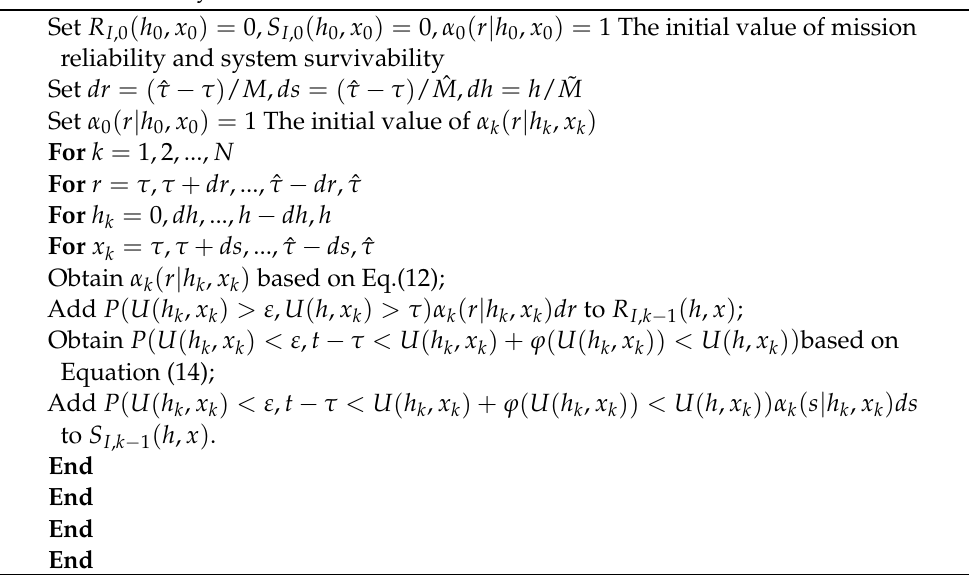
Algorithm 1: Recursive algorithm to determine the mission reliability and sys- tem survivability reliability and system